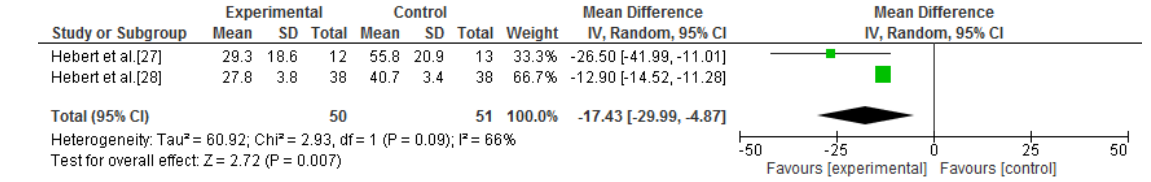
Figure 5. Forest plot of the meta-analysis of dizziness (vestibular rehabilitation versus no intervention).